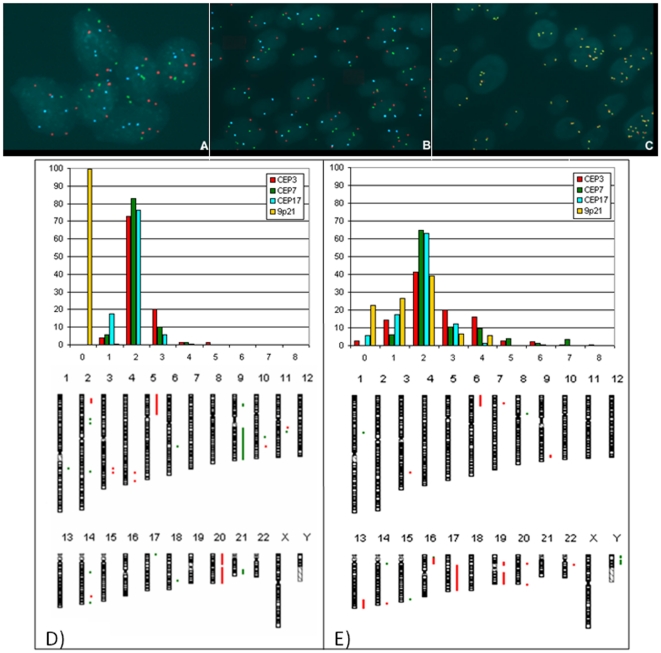
Examples of FISH analysis.Urovysion test applied to: (A): FIN sample 032CR07 (HG NI); (B): FFPE sample 080CR09 (LG NI). (C) FISH with PPARγ probe on 028CR09 (HGNI). Urovysion versus array-CGH data: example of concordant data (D), (sample 080CR09); and non-concordant data (E), (sample 004CR10).